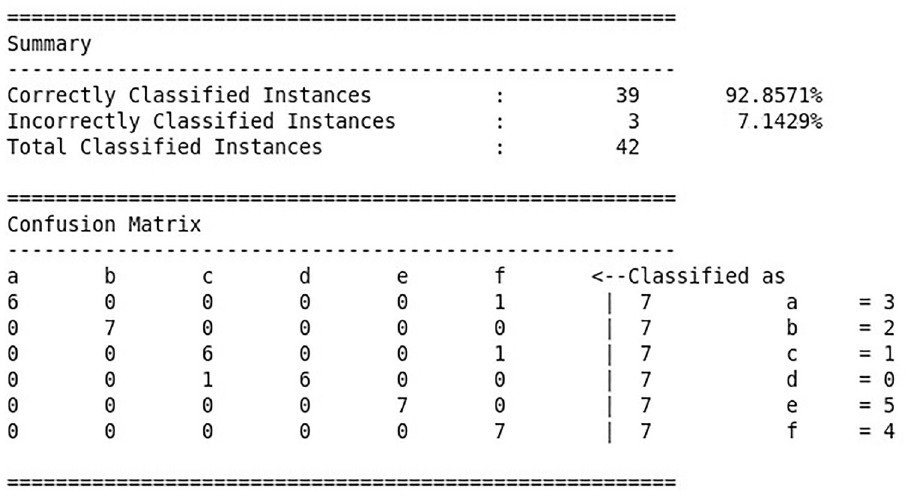
Fig 10. Test results of random forest